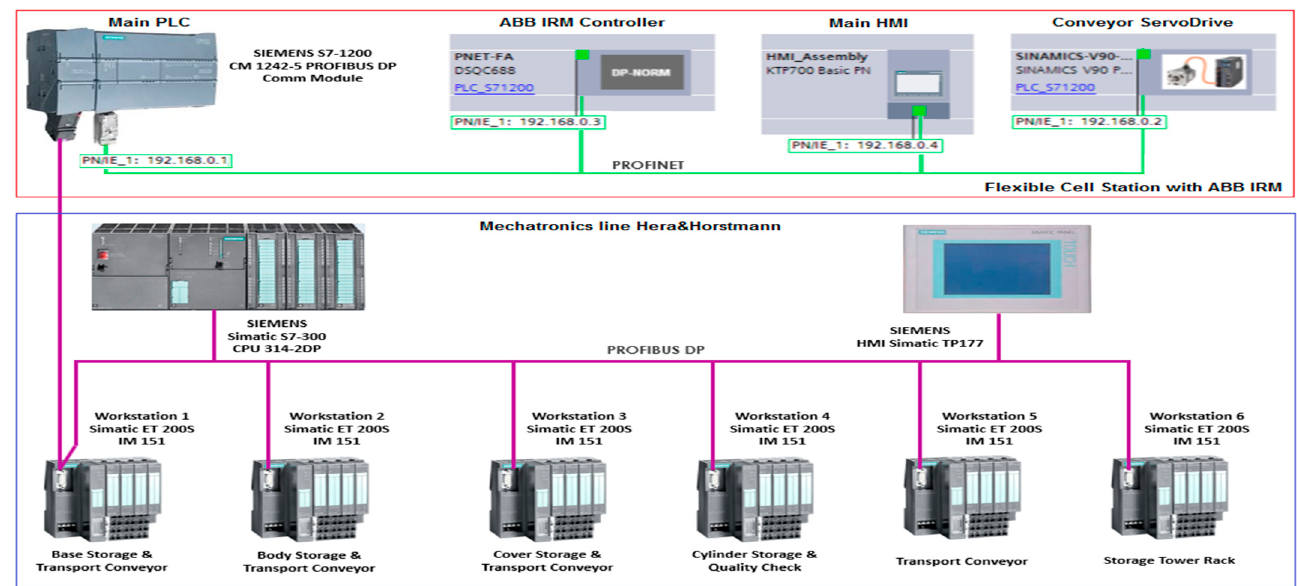
Figure 18. Real counterpart of A/D/RML communication and control architecture.